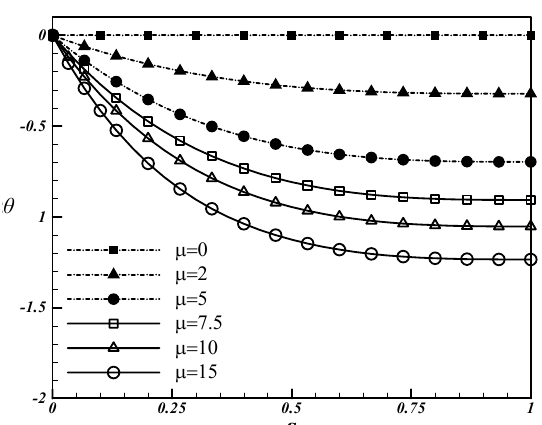
Fig.4. Effects of dimensionless weight parameter μ on angle of rotation. Figure 4. Effects of dimensionless weight parameter µon angle of rotation.